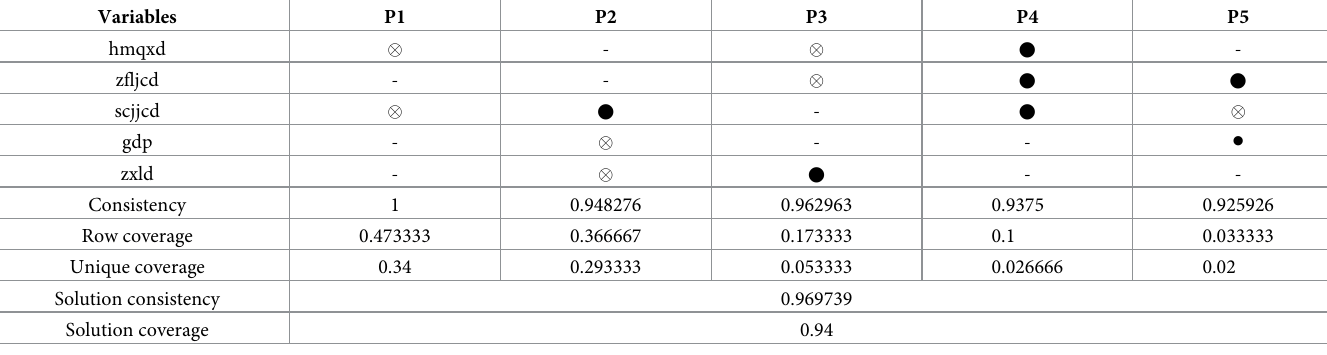
Table 7. Antecedent condition configuration of the increase in the growth rate of collusion